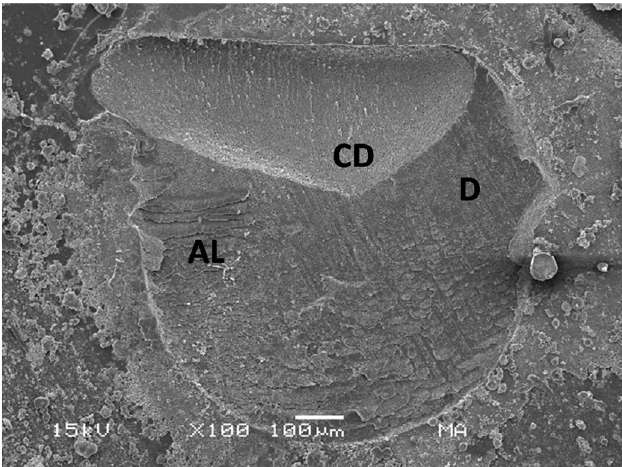
Fig. 1 - SEM photomicrograph illustrating a mixed fracture for Multilink (light-cured). Fracture within the dentin (CD) and failure between dentin and resin cement (AL: adhesive layer, D: dentin).